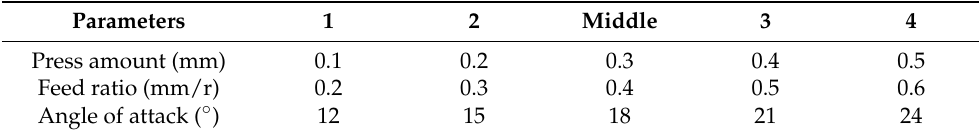
Table 4. Range of study parameters for the rotary ring spinning process.